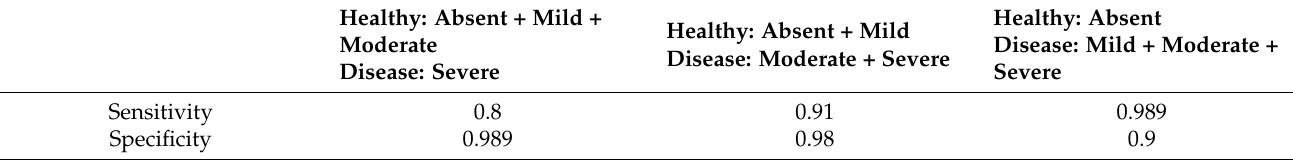
Table 5. Decision tree sensitivity and specificity calculation from stress scales